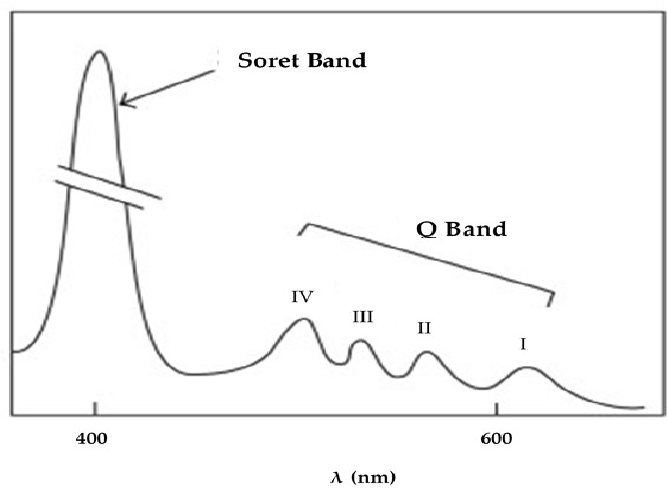
Figure A1. Typical absorption spectra of porphyrins [53].